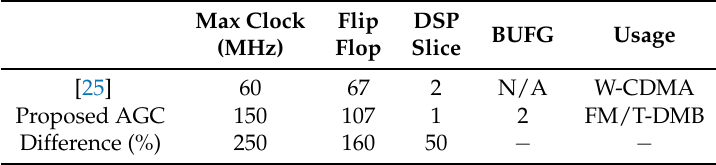
Table 8. Performance comparison of two digital AGCs.